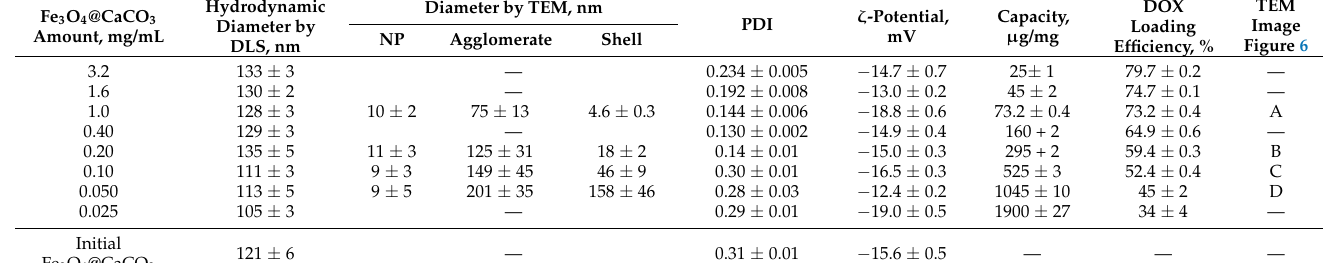
Table 2. Diameter by DLS and TEM, PDI, ζ -potential, and capacity of DOX-loaded nanocomposites Fe 3 O 4 @CaCO 3 /DOX.